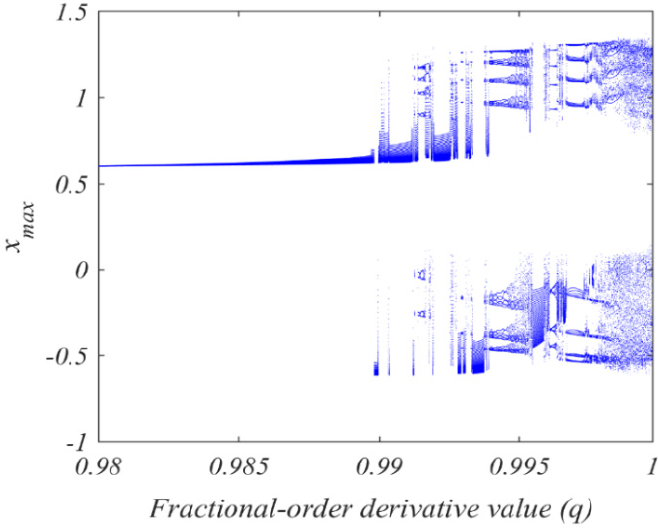
Figure 9. Bifurcation diagram, effect of the parameter α on the system state variable x ( t ) .